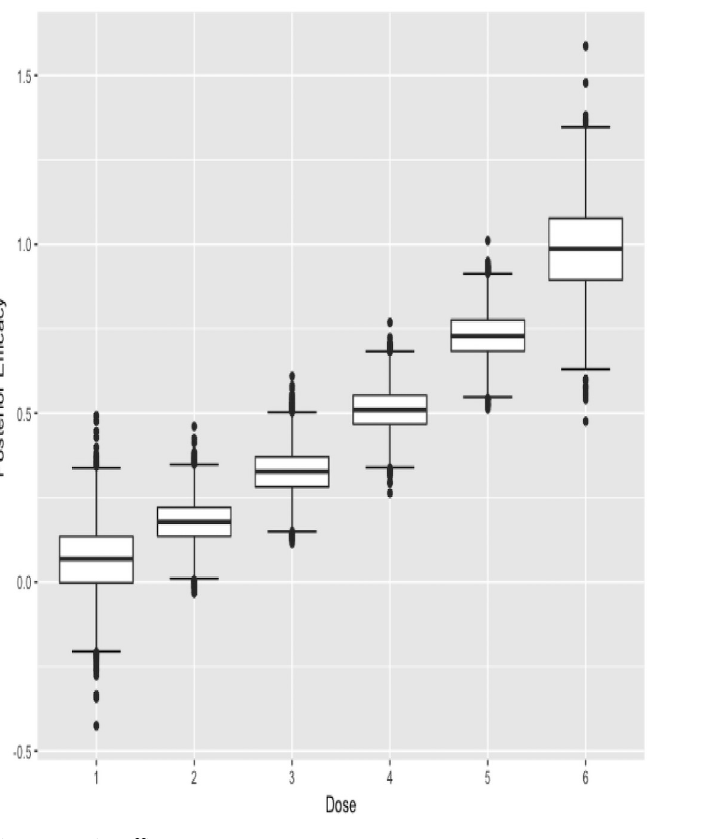
Fig 5. Posterior